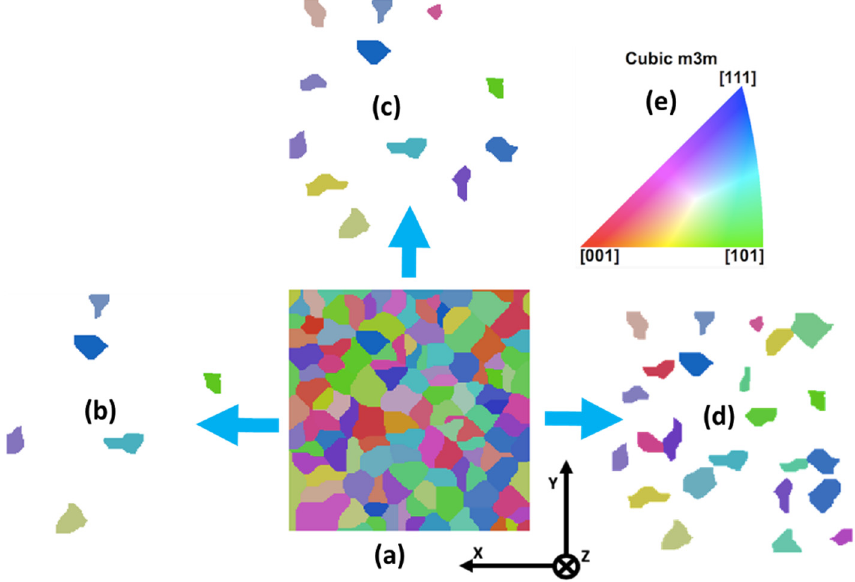
Figure 5. Selection of RVEs for creating local maps; ( a ) 100% austenite matrix ( b ) 5% zirconia particles, ( c ) 10% zirconia particles, ( d ) 20% zirconia particles, and ( e ) the IPF color scheme.